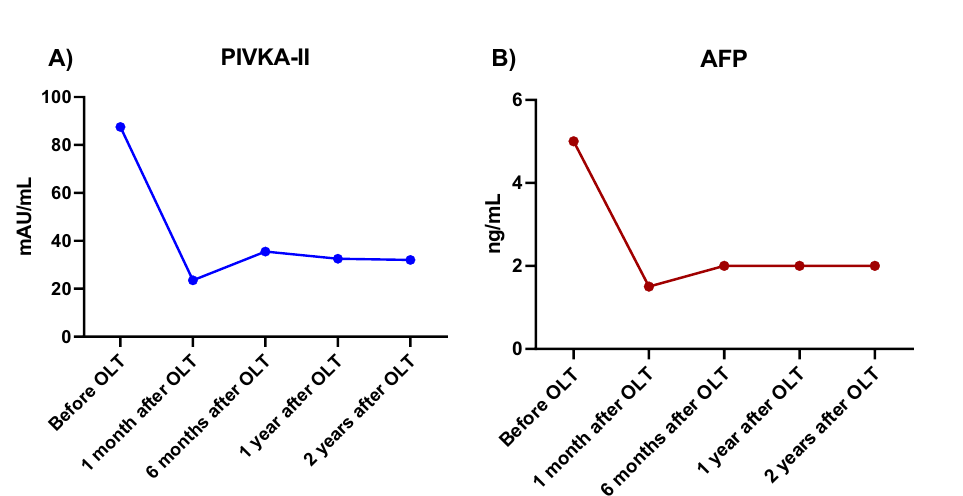
Figure 1. Evolution of median levels of PIVKA-II and AFP after OLT in patients with HCC. OLT orthotopic liver transplant.